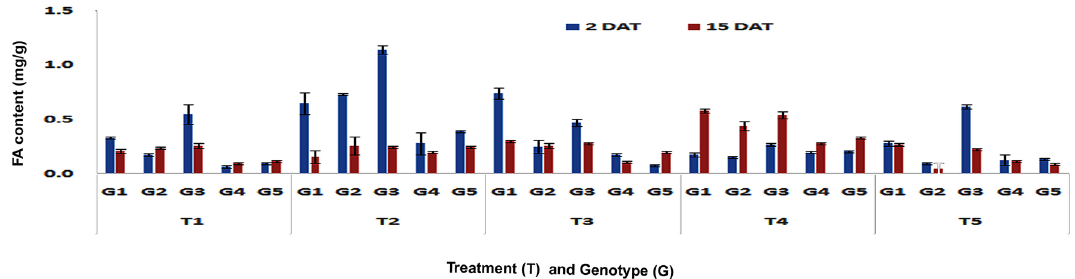
Figure 8. Changes in FA content in stalk tissues of maize genotypes to induced treatments in short (2 DAT) and long (15 DAT) term responses on the imposition of treatments at V6 stage (G1: DMRE 63; G2: CM 500; G3: WNZ Exoticpool; G4: CM 202; G5: BML 6; T 1 : Control; T 2 : PSB feeding; T 3 : Wounding; T 4 : Combination of wounding plus regurgitation; T 5 : Exposure to methyl